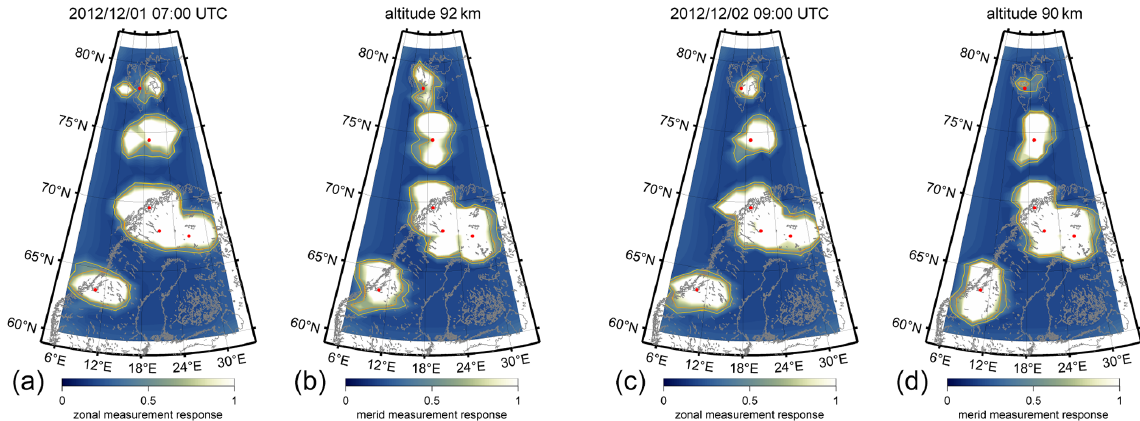
Figure 17. Measurement responses for the large-scale retrieval visualized with next-neighbor correlation corresponding to about 120km resolved